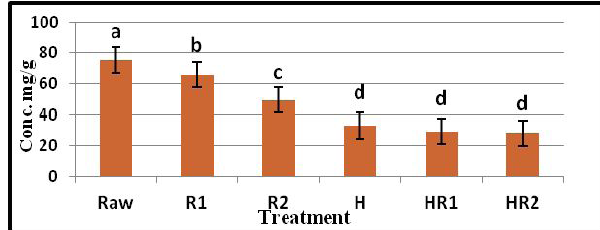
Fig. 1(b). Effects of γ-irradiation and/or extrusion on trypsin inhibitor of soy flour. a,b,c, means within same column followed by different letters are significantly different at (P<0.05), Val- ues are means of three replicates (± SE). Raw→ raw soy